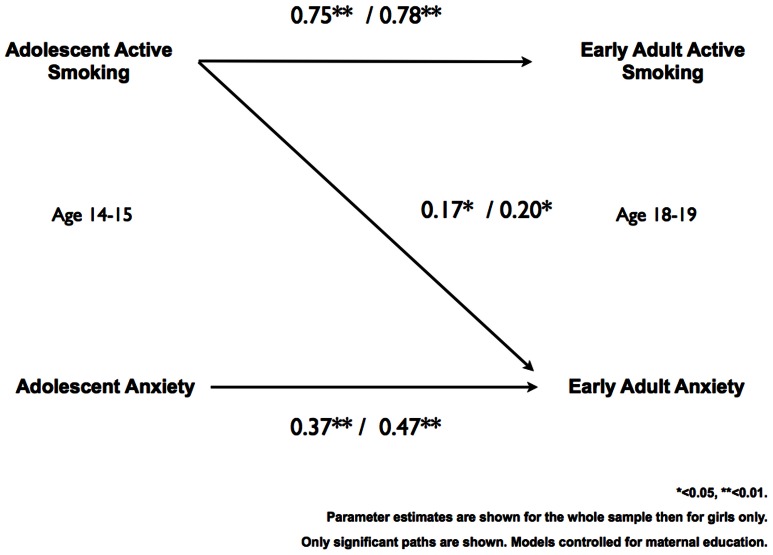
Structural model of associations between active smoking and anxiety scores in adolescence (age 14–15) and early adulthood (age 18–19).
Caption: Adolescent active smoking at age 14–15 years in the total sample and for girls only was associated with increased anxiety symptoms scores at age 18–19 years (β coefficients displayed for total sample first, then for girls only). * p<0.05, ** p<0.01. The model is adjusted for maternal educational level. Only significant paths are shown. All paths were estimated in the model (df = 0). Model fit perfect (χ 2 = 0.00, RMSEA = 0.000, TLI and CFI = 1.00). The path from Adolescent active smoking to early adult active smoking is a probit regression coefficient. When translated into probabilities, the results show that at a mean level of maternal education and adolescent anxiety, active smoking during adolescence has 65% risk of being active smokers in early adulthood, while non-active smokers during adolescence has a 36% risk of active-smoking in early adulthood.